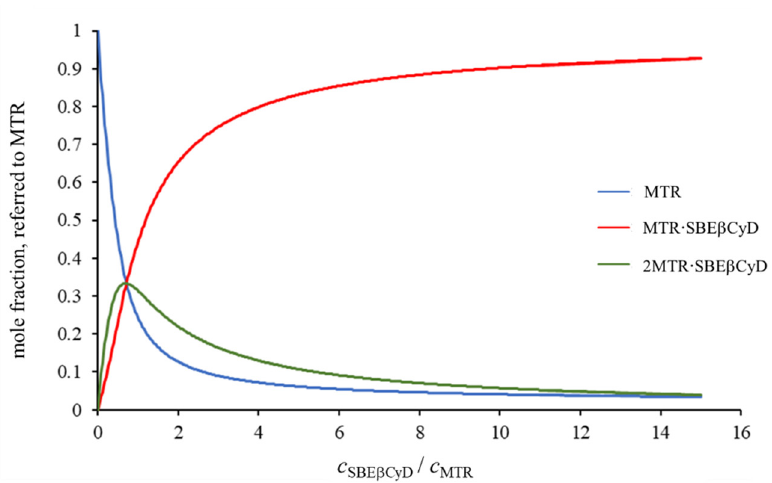
Figure 3. Species distribution plots for the 1 H NMR titration of MTR with SBE β CyD.